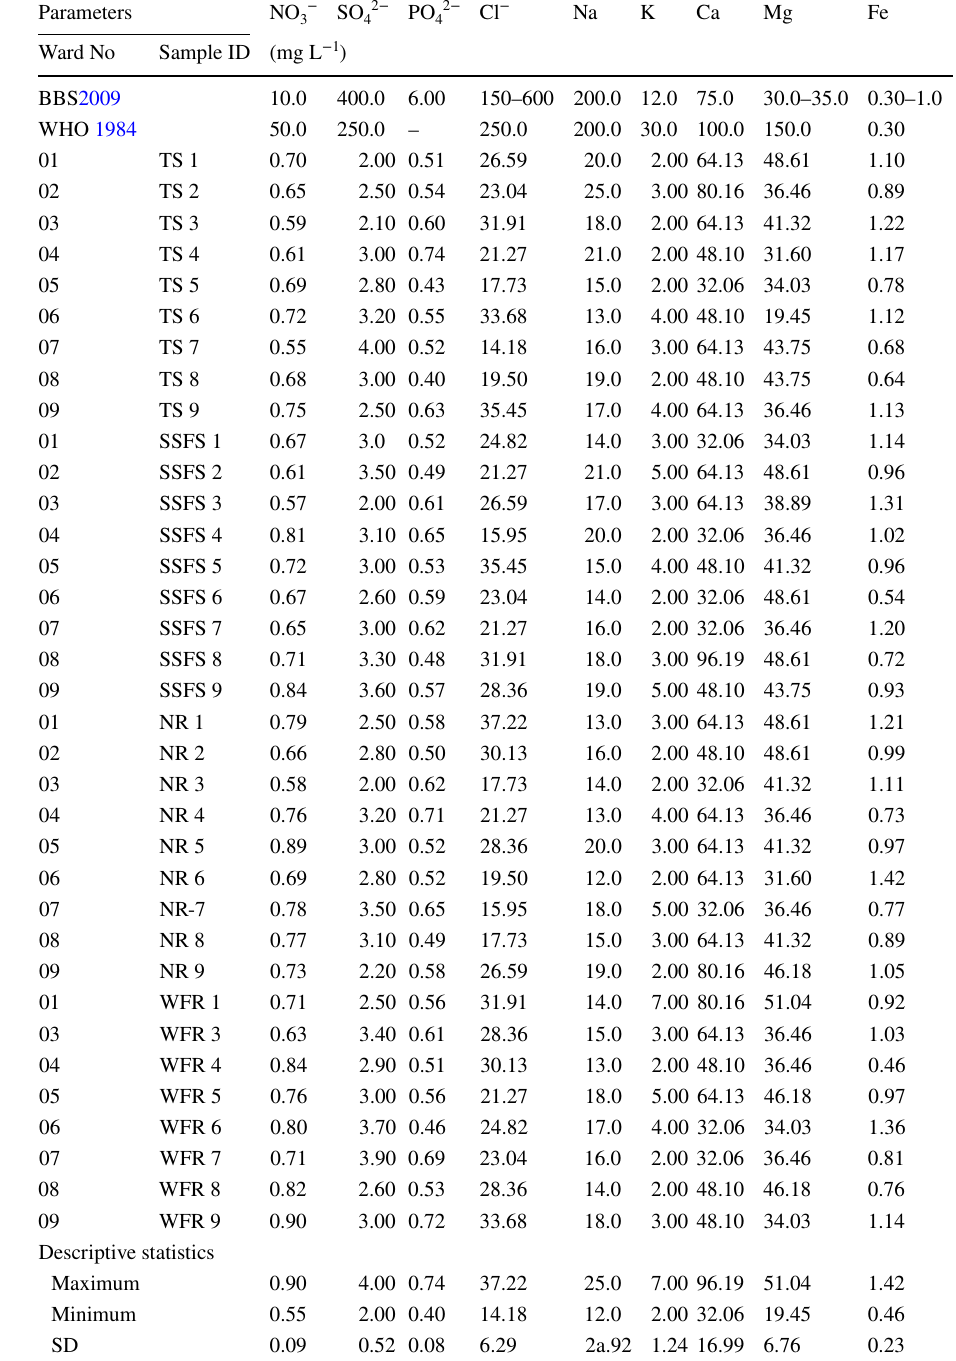
Table 2 Comparison of some chemical parameters with WHO & Bangladesh standards for drinking water of different food stalls & restaurants of Jashore